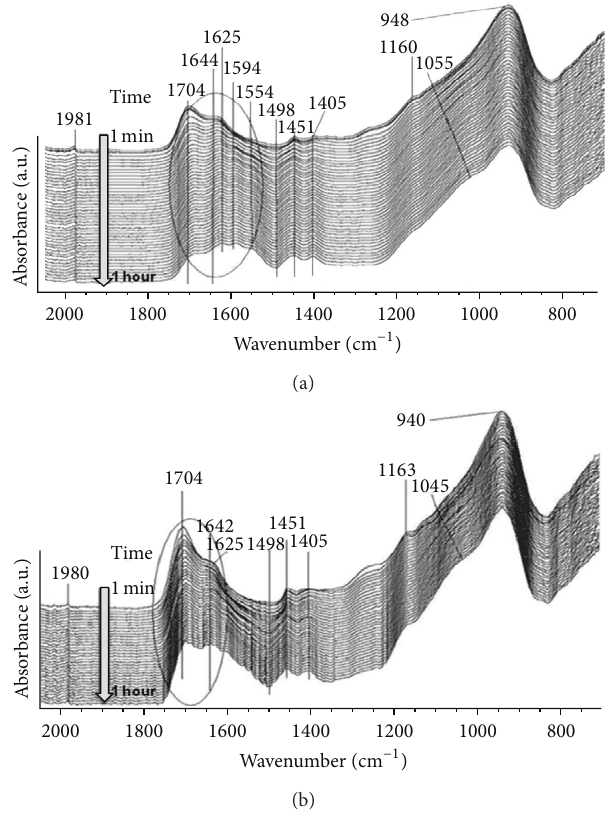
Figure 3: Real time FTIR analysis of the setting reaction of F-IX cement (a) and C-V cement (b) at different time intervals for one hour.